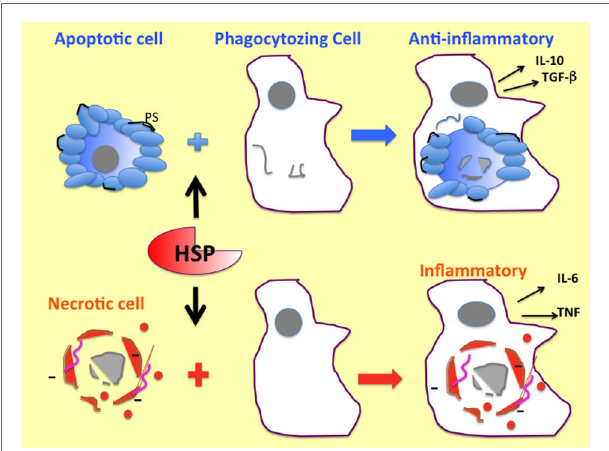
FiGURe 2 | Contrasting effects of cell corpses resulting from apoptotic and necrotic cell killing on immunity . Apoptotic cells, depicted here with surface blebs, externalize the phospholipid phosphatidylserine to the outer leaflet of the plasma membrane leading to anti-inflammatory signaling and suppression of immunity. Necrotic cells depicted here with compromised membranes release DAMPS, such as HMGB1 (small orange spheres), and acquire net negative charge. Nucleic acids (pink lines) become located to the cell surface. Necrotic cells often trigger release of inflammatory cytokines, such as IL-6 and TNF α . HSPs, such as Hsp70, trigger the phagocytosis of dead mammalian cells as shown here, although the mechanisms involved in such stimulation are currently not clear. Gray spheres indicate